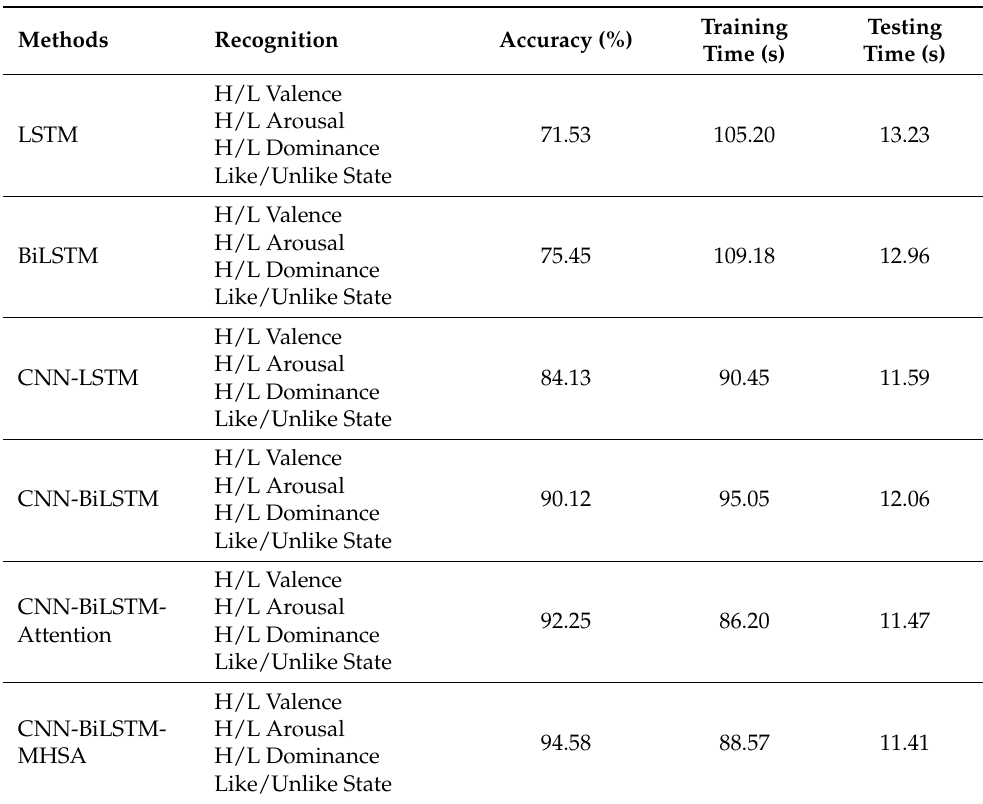
Table 7. Comparison with the base